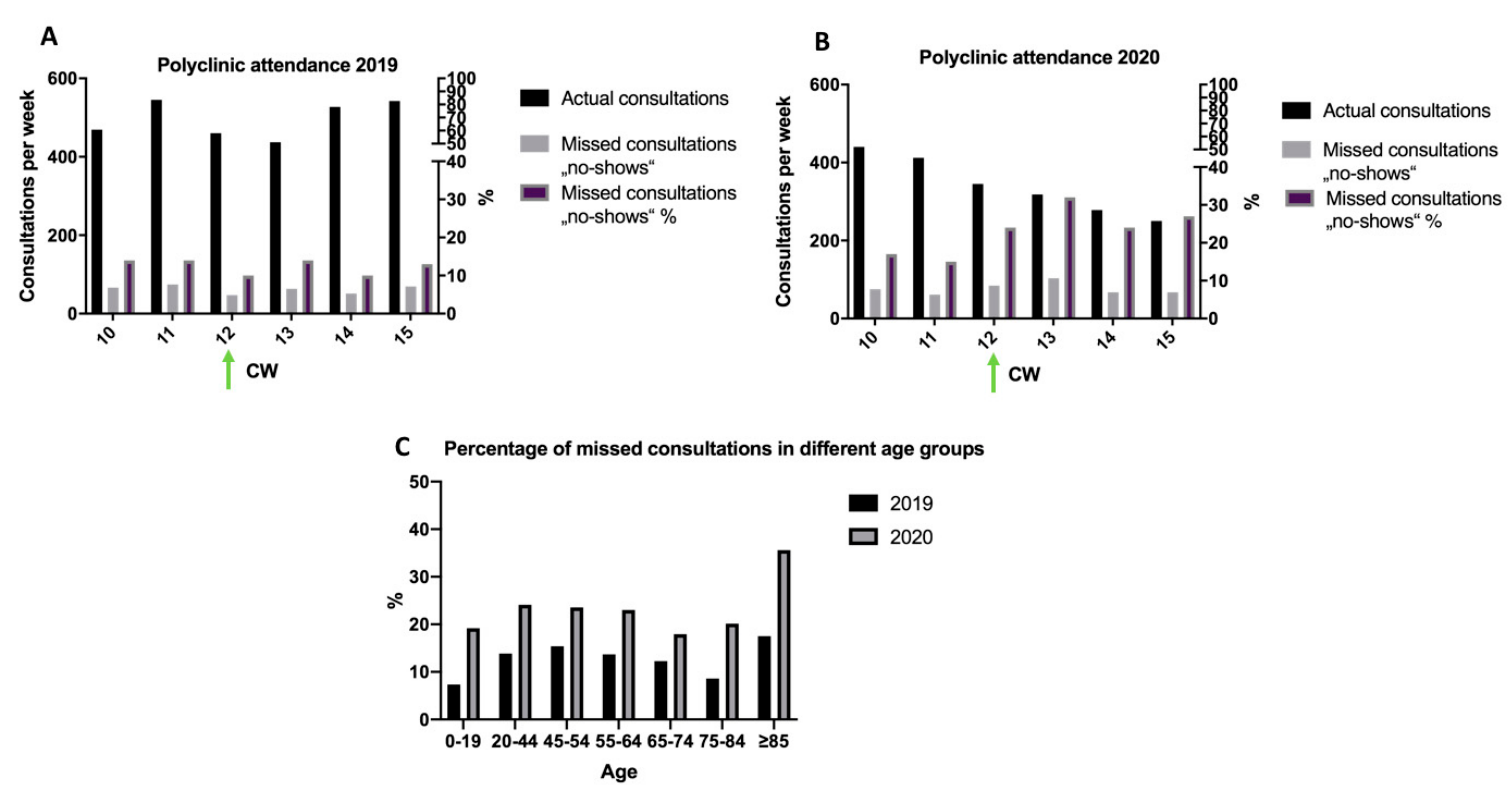
Figure 2. Polyclinic attendance. ( A ) Consultations per week between CW 10 and CW 15 in 2019. Actual consultations per week (black column) and missed consultations (no-shows; gray column) in the polyclinic presented on the left y-axis. Relative proportion of no-shows compared to total number of consultations (violet column) in the polyclinic illustrated on the right y-axis. Enforcement of exit and contact restrictions in Bavaria in CW 12 (green arrow). ( B ) Consultations per week between CW 10 and CW 15 in 2020. Actual consultations per week (black column) and missed consultations (no-shows; gray column) in the polyclinic presented on the left y-axis. Relative proportion of no-shows compared to total number of consultations (violet column) in the polyclinic illustrated on the right y-axis. Enforcement of exit and contact restrictions in Bavaria in CW 12 (green arrow). ( C ): Percentage of missed consultations (no-shows) in the polyclinic clustered in different age groups between March and April 2019 (black) and 2020 (gray). CW, calendar week.